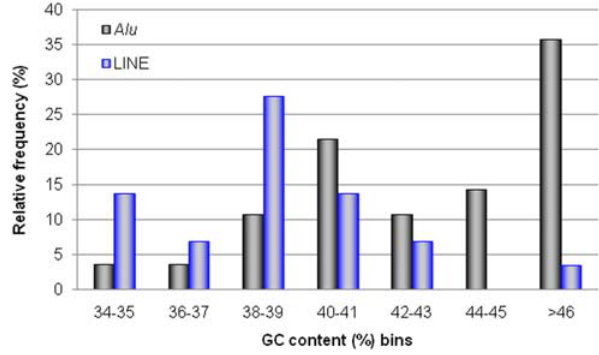
Figure 4. Analysis of GC content in flanking regions of RRMI loci. The vertical axis represents the relative frequency of RRMI loci within each GC bin. Black bars and blue bars indicate Alu -RMD and L1- RMD events, respectively.